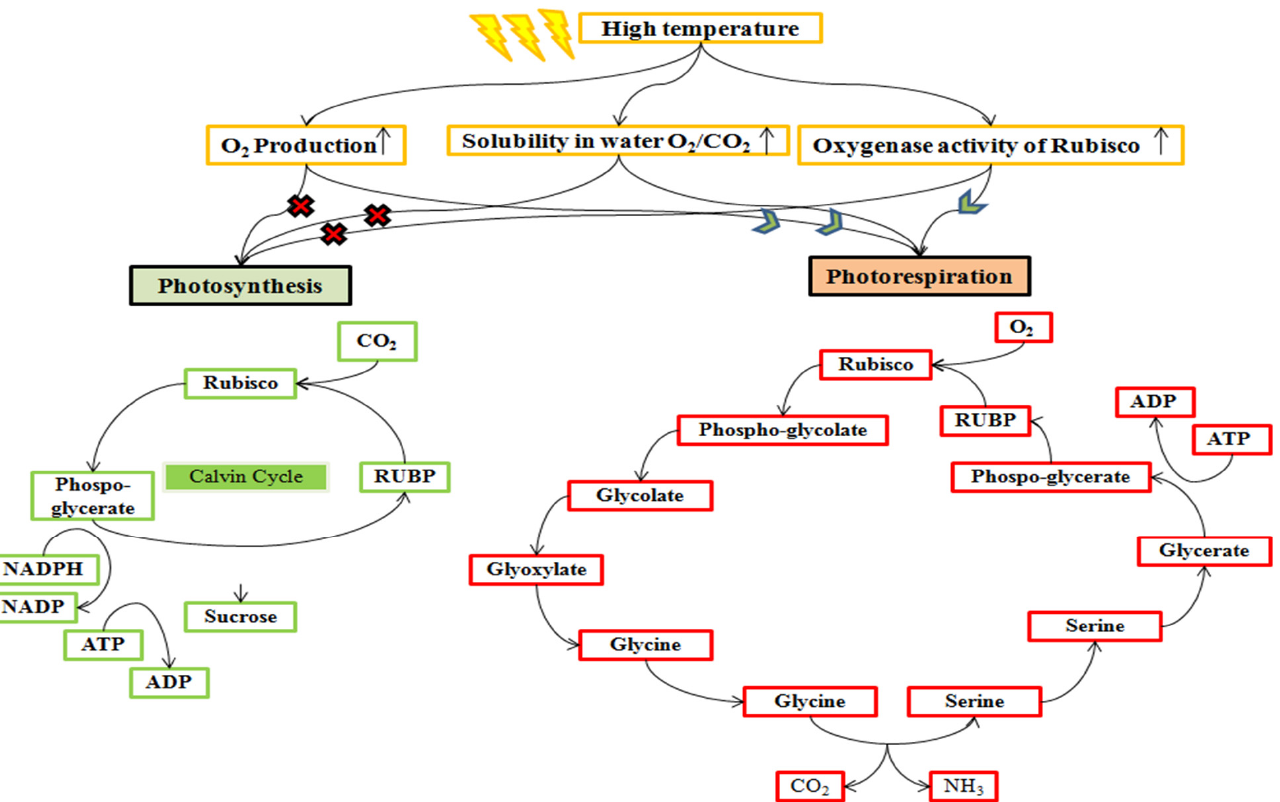
Figure 5. Rubisco enzyme activity pathway alteration at a high temperature. Rubisco has a characteristic of both oxygenation and carboxylation activities. High temperature increases the synthesis of oxygen through photosynthesis, which enhanced the solubility of oxygen than carbon dioxide. Therefore, it promotes the oxygenase activity of Rubisco and stimulates photorespiration, which compartmentalized in chloroplast, peroxisomes, and mitochondria.